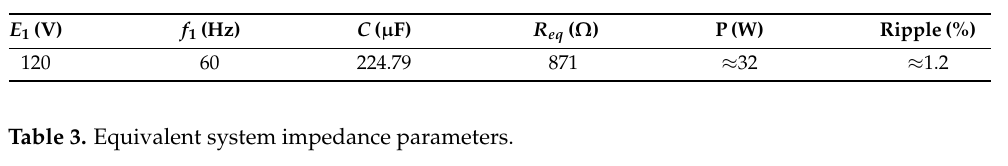
Table 2. Circuit parameters.